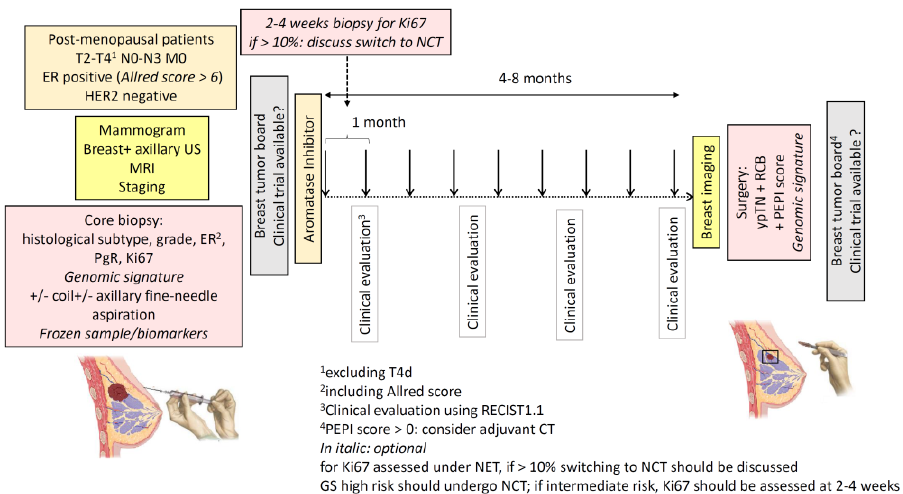
Figure 1. Summary of a proposal for optimal NET management. Figure 1. Proposal for optimal NET management. Postmenopausal women with clinical stage II or III ER-positive,